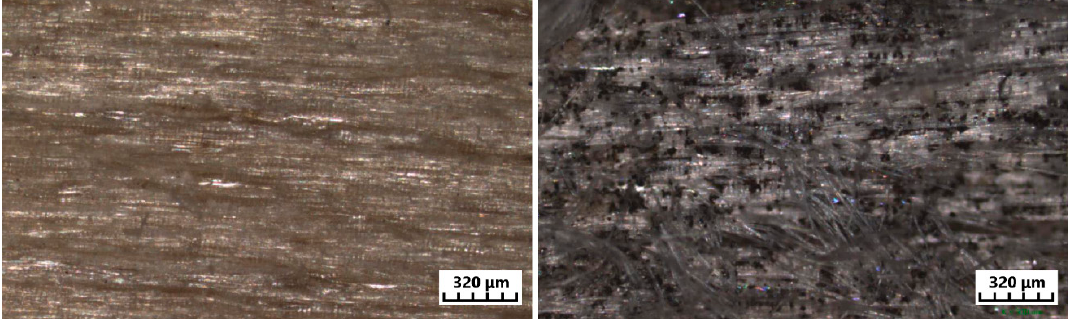
Figure 10. Confocal laser scanning microscopy of poplar wood before and after 2 years of weathering (detail).